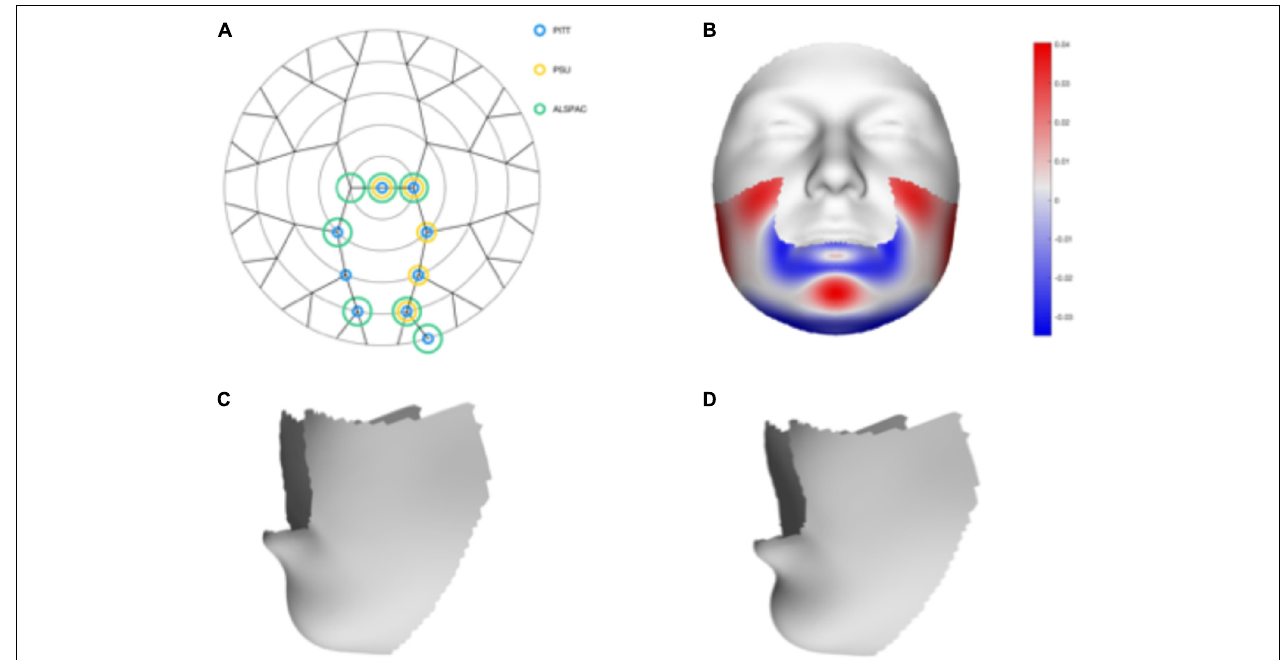
FIGURE 2 | Meta-analysis results for rs12150660. (A) Representation of the significant modules of the meta-analysis based on the different discovery datasets. (B) Heat map displacement plot of the effect of rs12150660 on facial morphology, with red representing an outward displacement and blue representing an inward displacement. (C) Surface warp showing the effect (exaggerated) of the major allele (G) on lower facial shape. (D) Surface warp showing the effect (exaggerated) of the minor allele (T) on lower facial